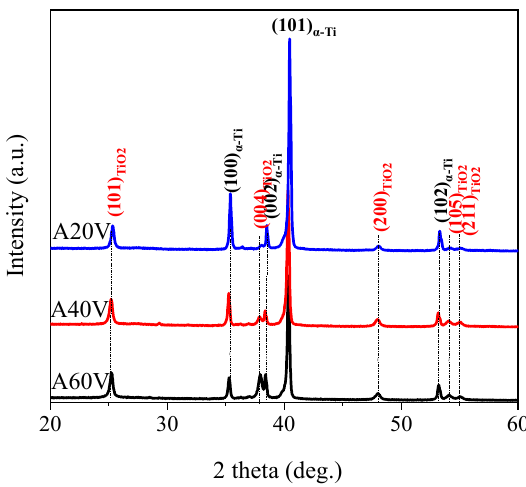
Figure 1. XRD patterns of various anodized specimens.